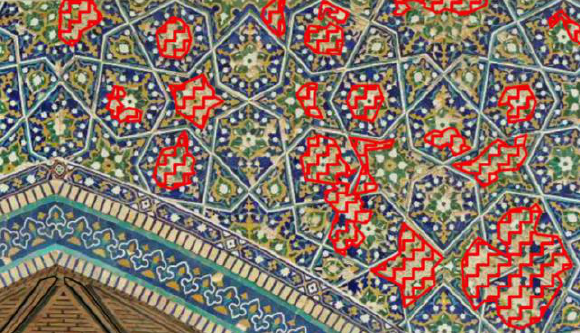
Figure 12 . Detail of majolica of the of the north façade of Miri- Arab Madrassah with orthophoto as background. Source: authors.